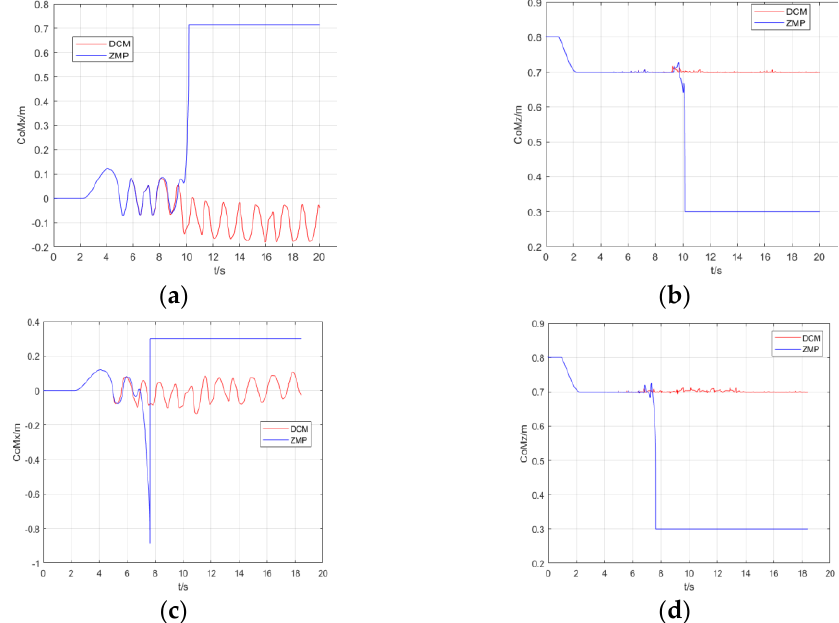
Figure 10. Comparison of ZMP and DCM. ( a , b ) Results in simulation 2. ( c , d ) Results in simulation 3. ( a ) Displacement in the coronal plane of the CoM. ( b ) Variation in the height of the CoM. ( c ) Displacement in the coronal plane of the CoM. ( d ) Variation in the height of the CoM.